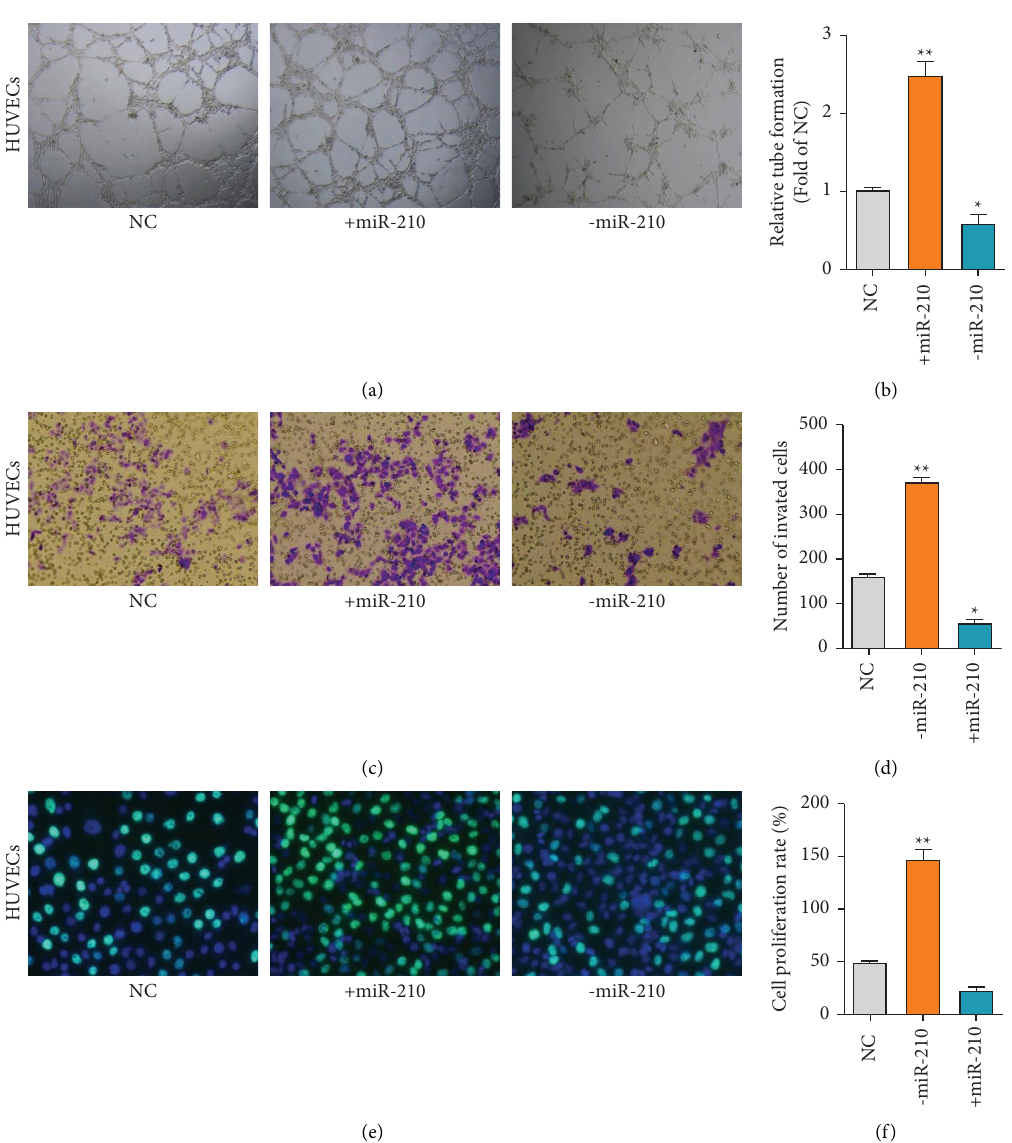
Figure 3: miR-210 promotes tumor angiogenesis, cell invasion, and proliferation in HUVECs. (a–b) Te angiogenesis abilities of the indicated treated HUVECs measured by tube formation assays. Scale bars � 50 μ m. (c–d) Te invasion abilities of HUVECs were measured by transwell assays. Scale bars � 50 μ m. (e–f) Te proliferation abilities of the indicated treated HUVECs were measured by EdU assays. Magnifcation, ×